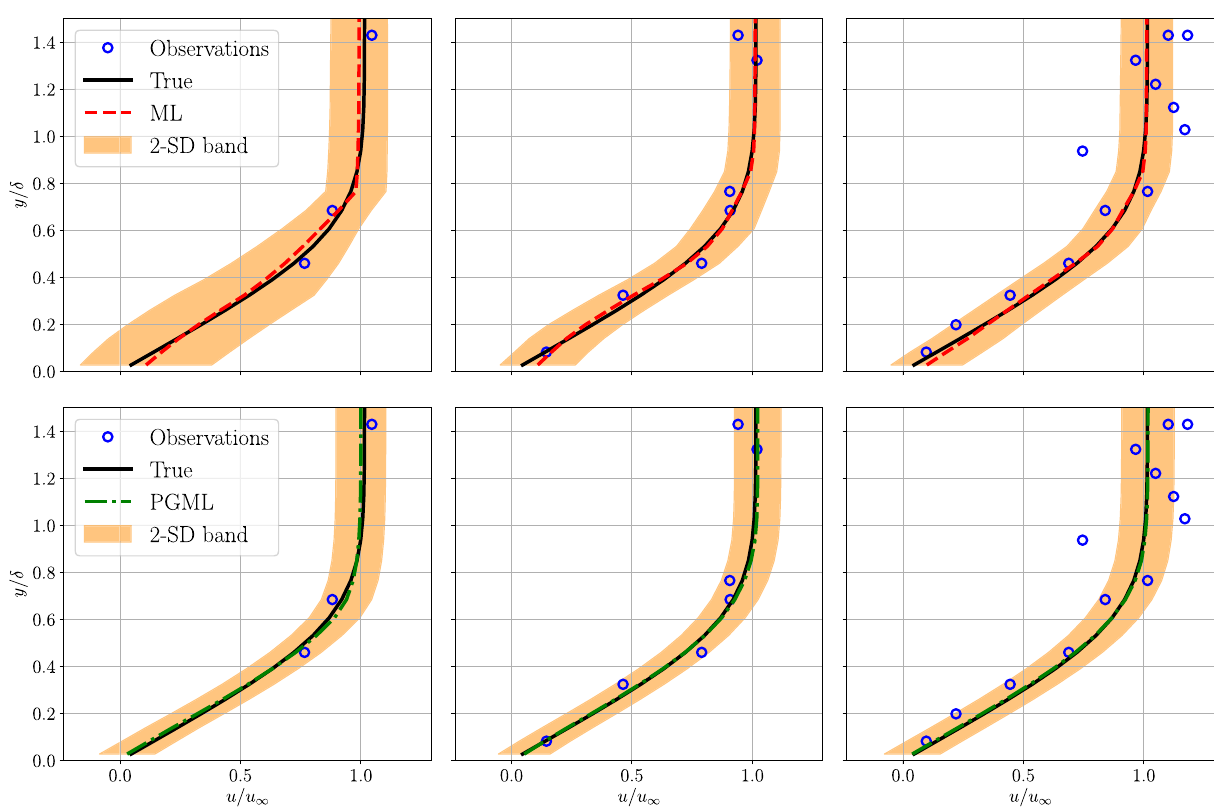
Figure 3. Boundary layer prediction for laminar flat plate flow at x / L = 0.5 along with the observations used for training the ML and PGML model. The amount of observations data used for training the model is 10% (left), 30% (middle), and 50% (right). The shaded area corresponds to two standard deviation (2-SD)